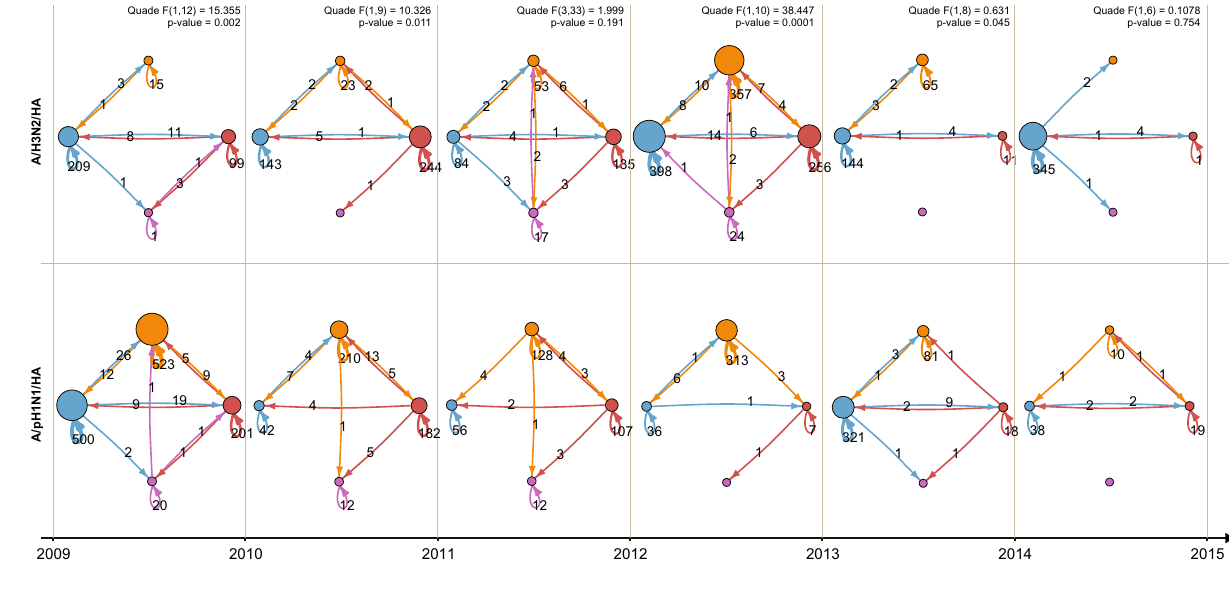
Figure 2. Network reconstruction of viral spread between the sampled geographic locations show increased spread of influenza A/H1N1 (bottom row) compared with influenza A/H3N2 (top row) between 2009–2011, followed by an opposite trajectory between 2011–2013. Inferred viral spread networks between geographic locations are depicted between centers located in Asia (red), Europe (orange), North America (blue) and Pacific (purple). Viral spread events during a 1-year time window were pooled and numbers were shown on the arrows. The diameter of the nodes is proportional to the number of sink viral spread events, while the arrow width is proportional to the number of source spread events. The Quade test and correspondent post-hoc procedures were applied to test significant differences between spread trends and preferred viral spread trajectories are presented at the top. Significance level was set to 0.05.